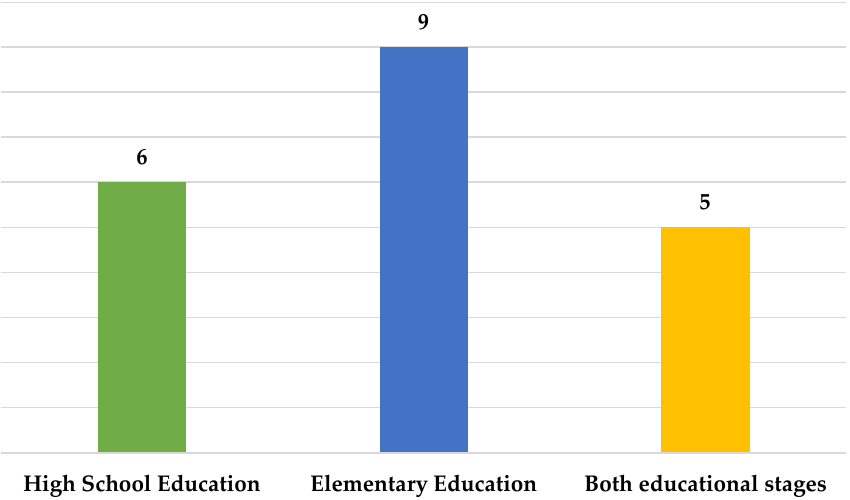
Figure 2. Evolution of scientific output of total articles and selected articles.